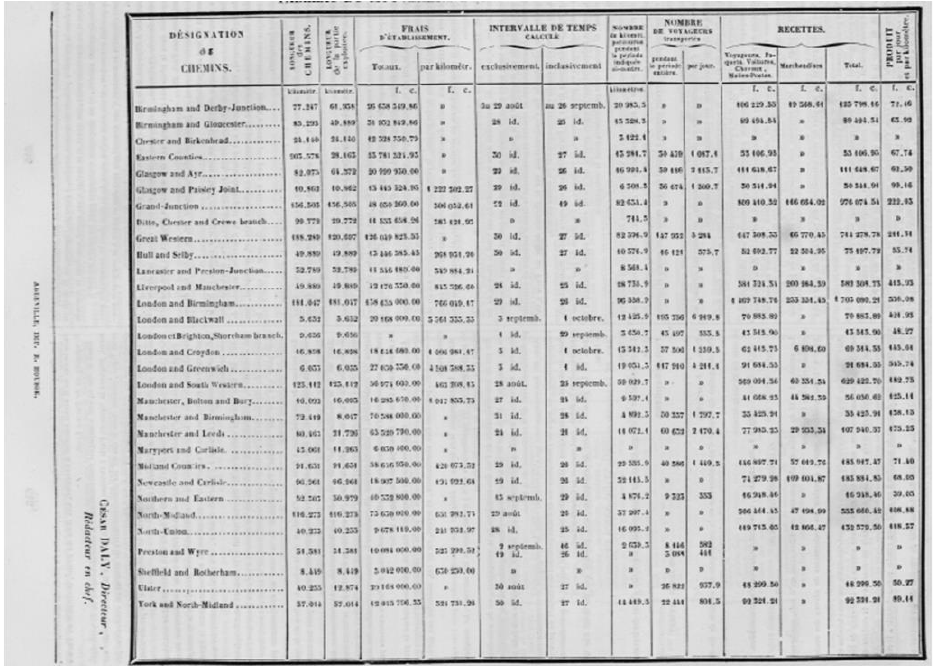
Figure 32. Example of one of the data tables on the movements of light metal slabs accompanying the article “ Metallic slabs ” , signed by Louis-Philippe and published in the “ Revue Générale de l ’ architecture et des travaux publics ” , France, 1840. Vol.10, col. 647. Edited by César Daly. [59].